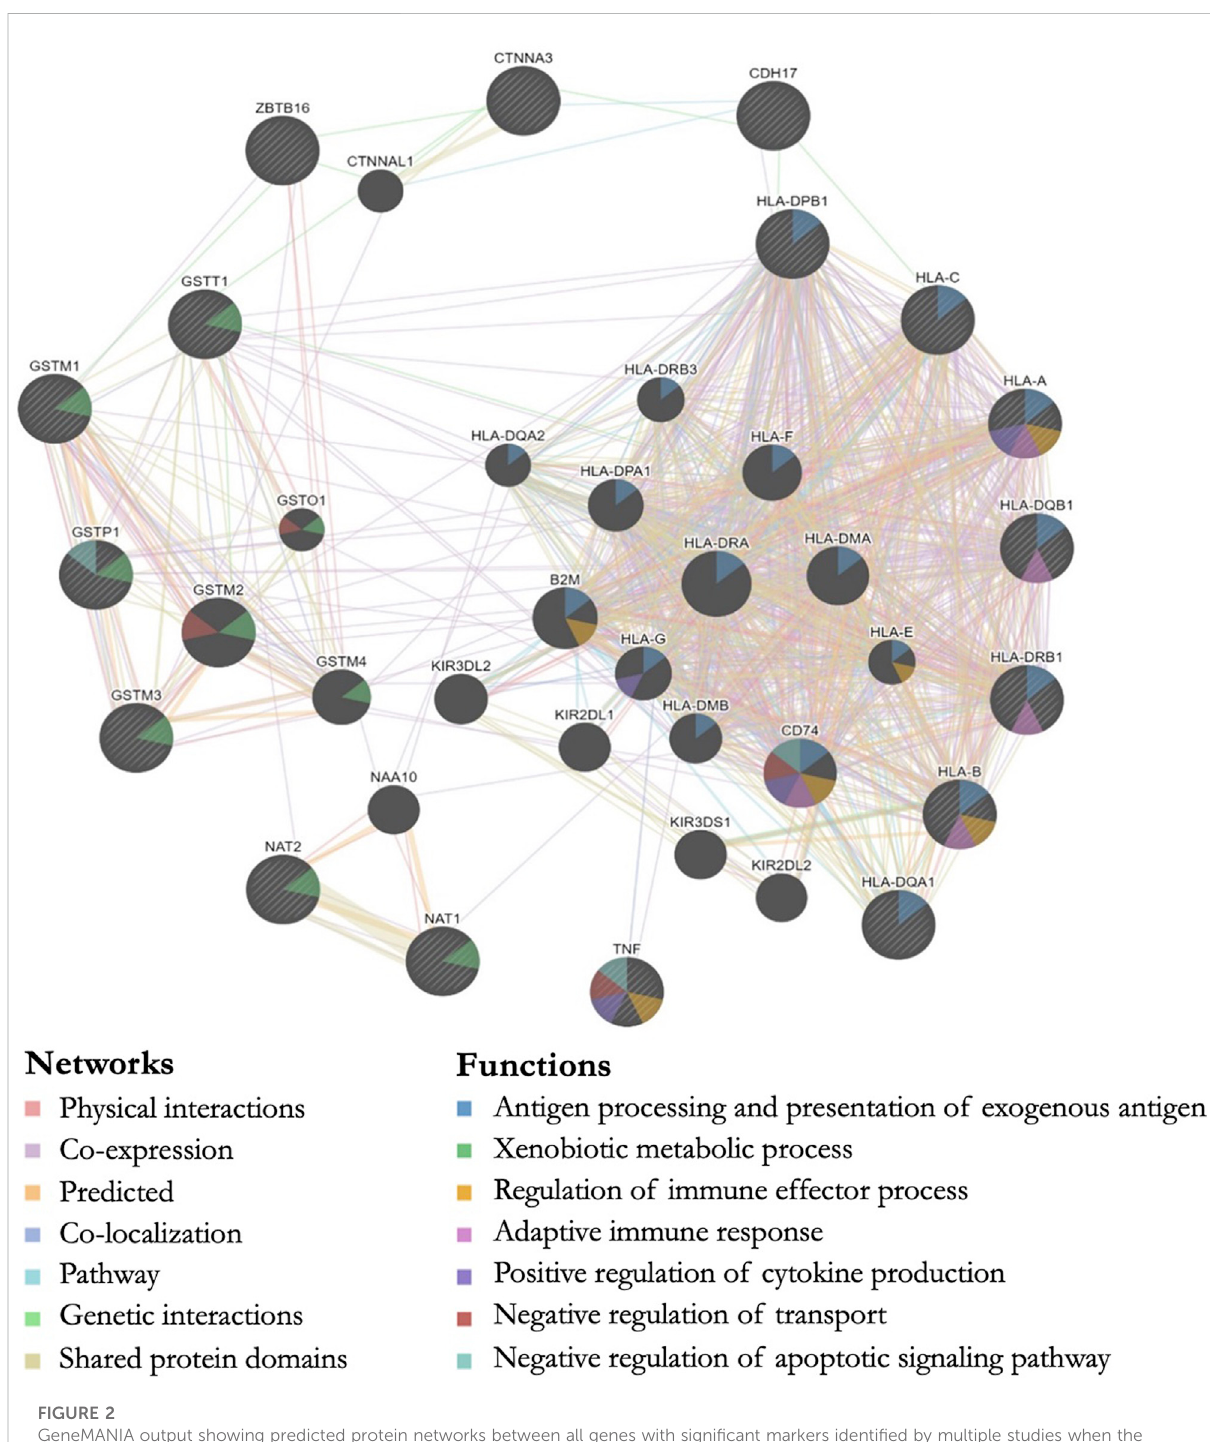
FIGURE 2 GeneMANIA output showing predicted protein networks between all genes with signi fi cant markers identi fi ed by multiple studies when the geneticsofworkerswithdiisocyanate-asthma(DA)wascomparedtoasymptomaticworkers(AW)orunexposedhealthynormalcontrols(NC).Query geneshaveblackcircleswithwhite-stripedlines,thenetworksareshownwiththecoloredlinesbetweengenes,andtheshadingonthecirclesshows the